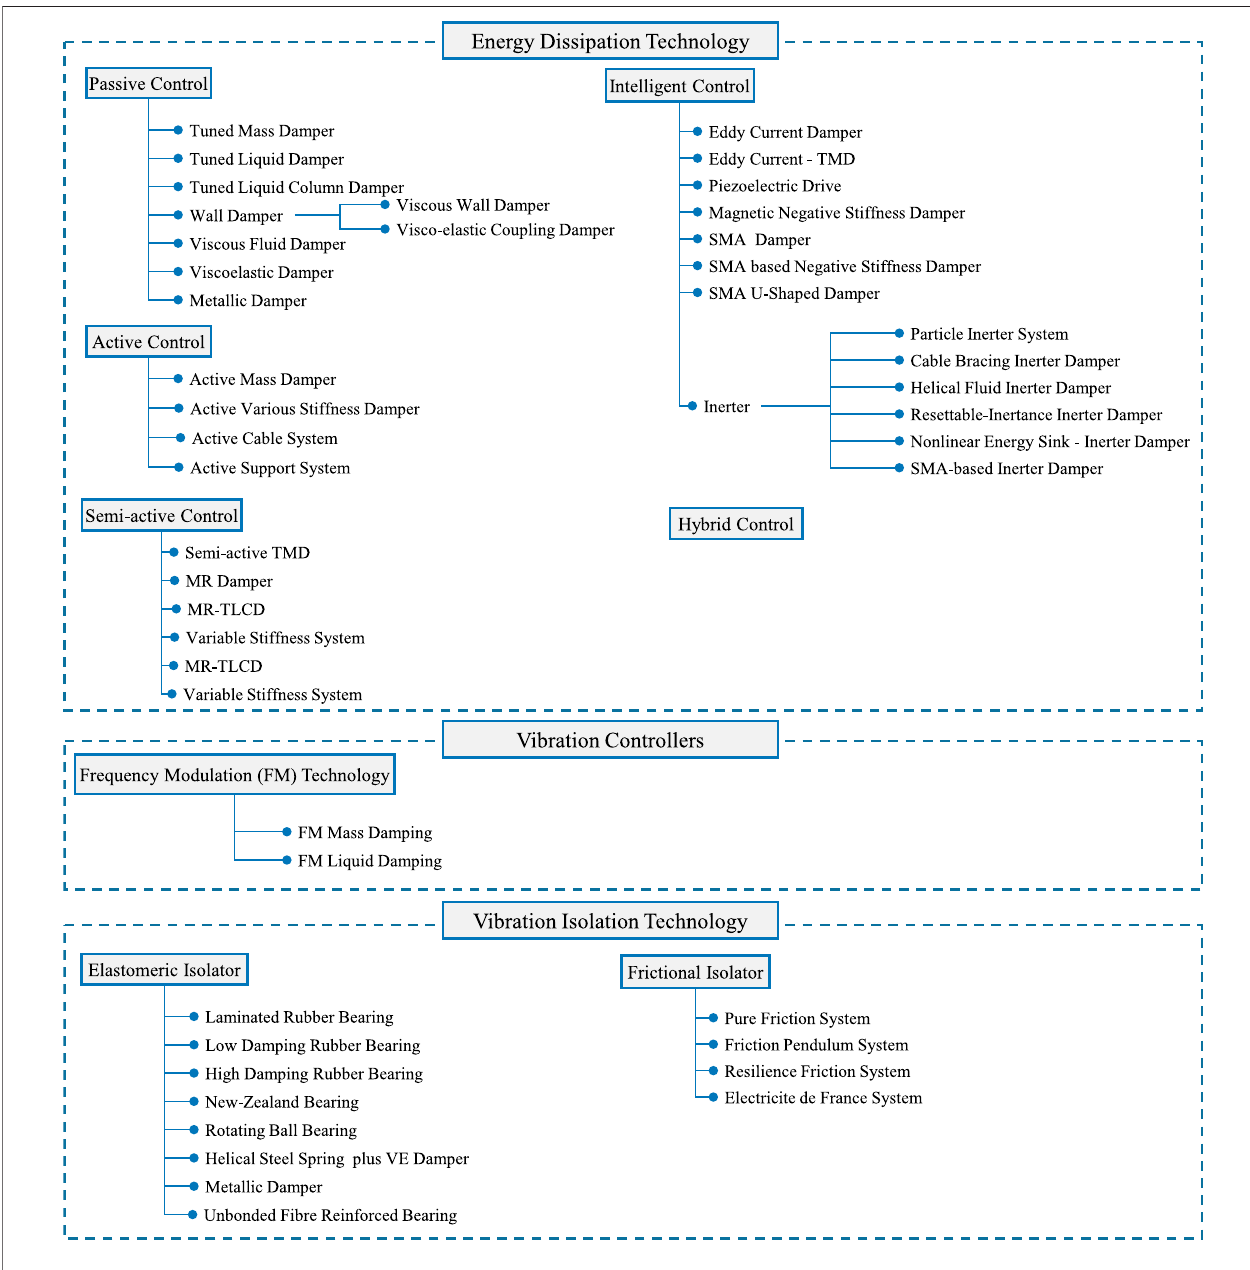
FIGURE 5 | General classi fi cation of supplemental energy dissipation devices.